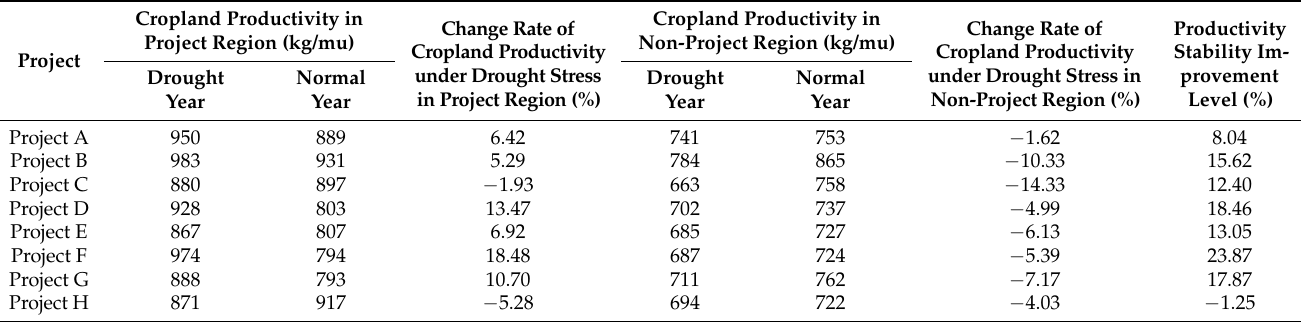
Figure 7. Dynamic change in the cropland productivity of HSF construction in drought and nor- mal years. Table 6. Statistics of productivity stability improvement in sampling project